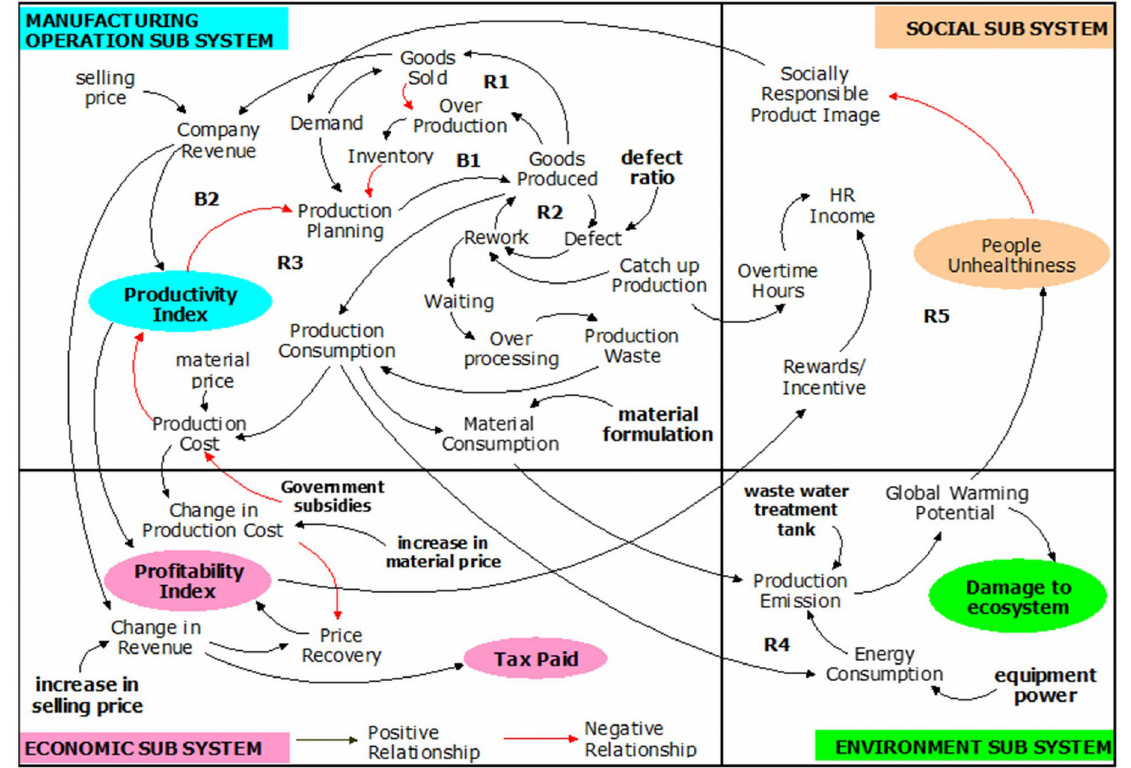
Figure 5. Conceptual models for sustainable cosmetics SMIs with causal loop diagrams